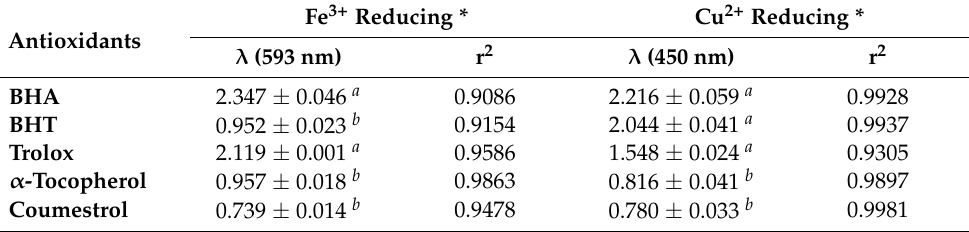
Table 1. Fe 3+ - and Cu 2+ -reducing activities of Coumestrol and of standards at 30 µ g/mL. Fe 3+ Reducing * Antioxidants